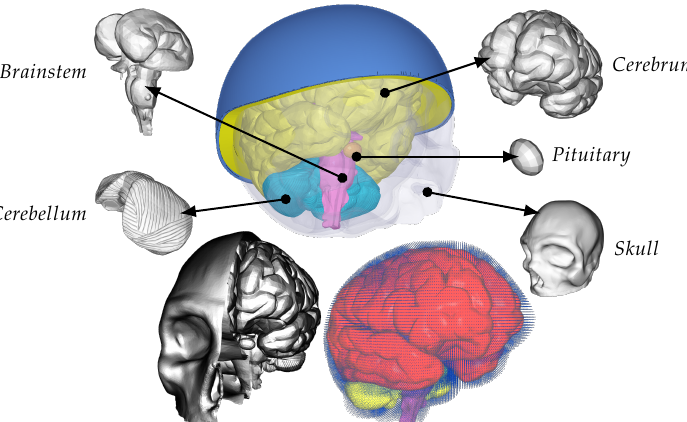
Figure 2. The model comprises different parts such as the skull, cerebrum, cerebellum, pituitary gland, and brain stem along with subarachnoid space and other cavities filled with fluid particles. Additionally, displayed is half of the skull to give better insight into its structure. The helmet included in the model has two layers; an outer hard-shell cover, colored blue, for protection, and inner padding, highlighted in yellow, for comfort purposes.